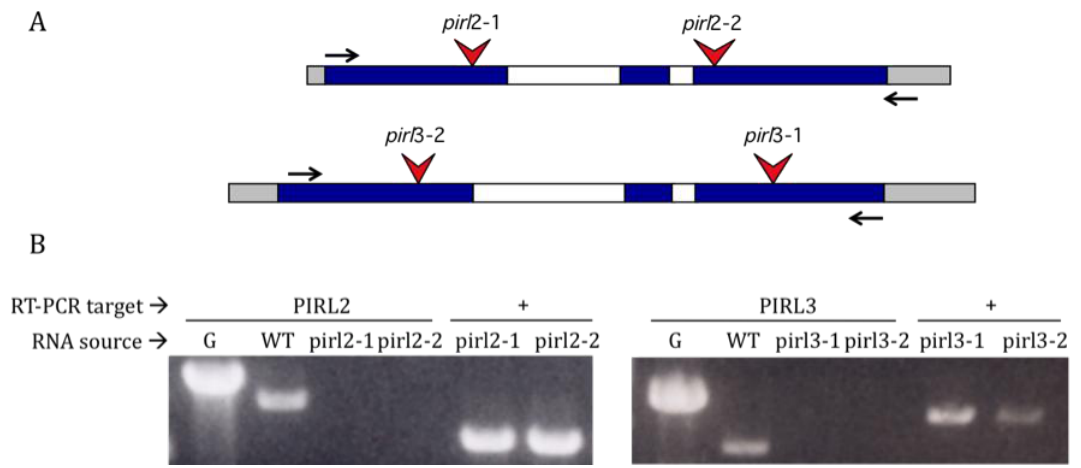
Figure 2. PIRL2 and PIRL3 T-DNA insertion alleles and knockout status. ( A ) PIRL2 and PIRL3 gene maps , with exons shaded and introns shown in white; light gray shading indicates UTR regions. Positions of T-DNA insertions in pirl2-1 , pirl2-2 , pirl3-1 , pirl3-2 alleles are indicated by red arrows. Horizontal arrows indicate positions of RT-PCR primers used for part B; ( B ) Confirmation of knockout status in pirl2 and pirl3 DNA insertion lines. RT-PCR was carried out with gene-specific primers on total RNA isolated from flowers or leaves of homozygous mutant (pirl2-1 , pirl2-2 , pirl3-1 , or pirl3-2 , as indicated) or wild-type (WT) controls. G, PIRL gene (with introns) amplified from genomic DNA. (+) lanes contain RT-PCR products for PIRL9 or PIRL1 amplified from pirl2 or pirl3 mutants, respectively, as positive controls for RNA quality and RT-PCR